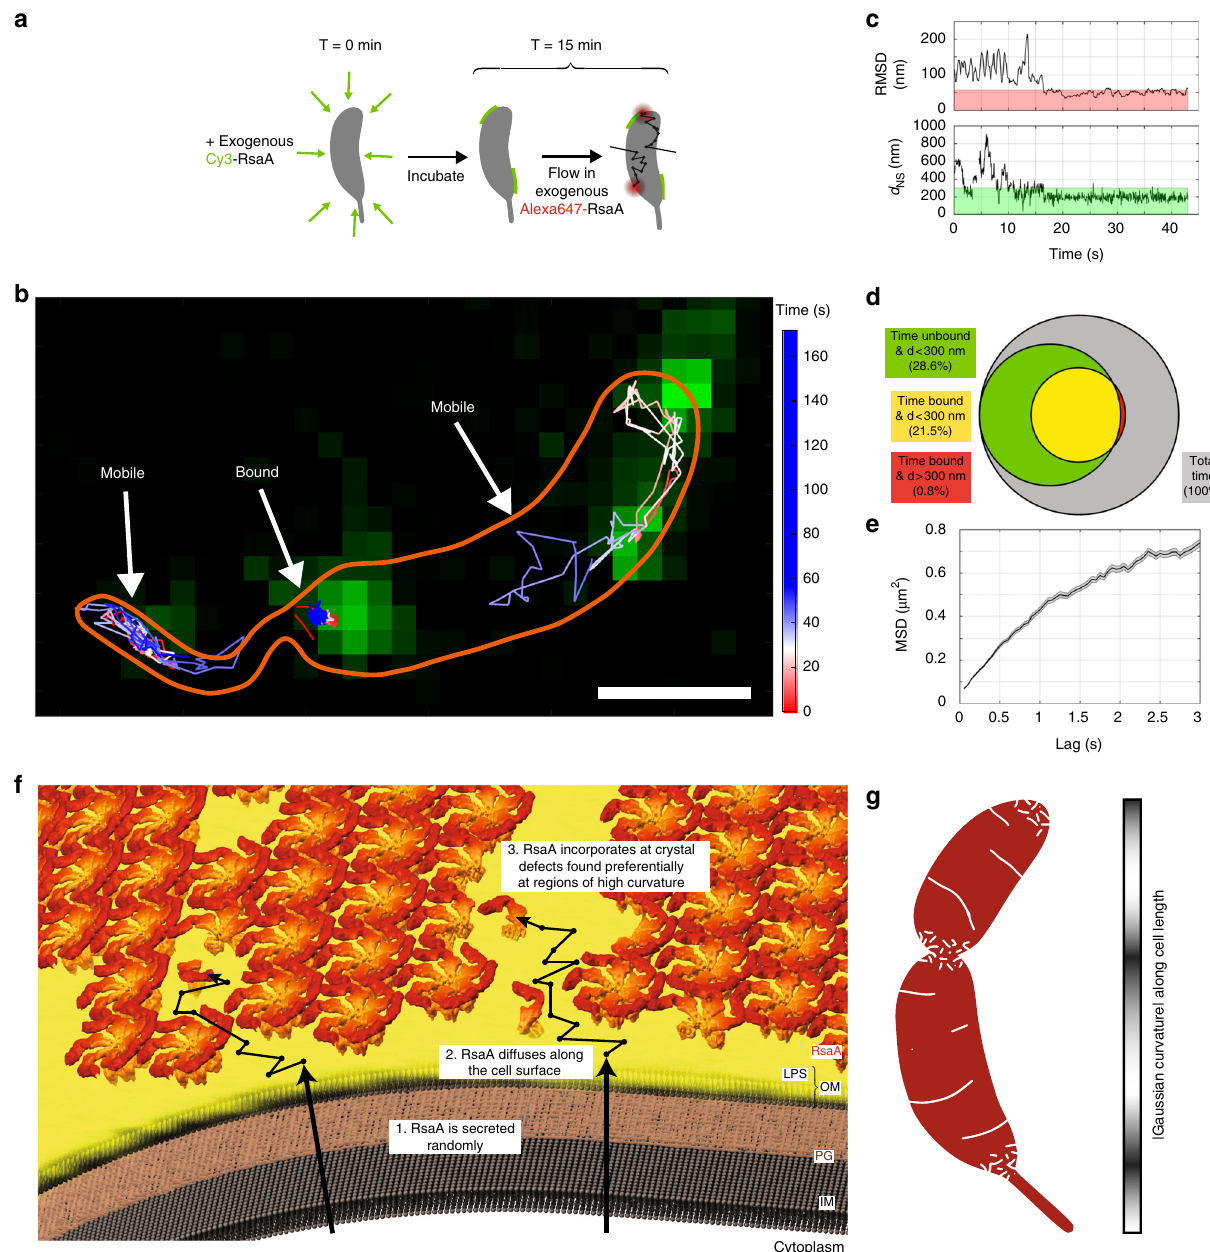
Fig. 4 RsaA monomers diffuse on the outer surface and bind to S-layer crystals. a Schematic of 2D, 2-color single-molecule tracking of CysRsaA on a Δ RsaA cell. Cells were incubated with 2.5 nM Cy3-labeled CysRsaA (green) to create small fl uorescent seed crystals. Single molecules of AlexaFluor647 labeled CysRsaA diffused through the agarose mounting pad and bound to the cell surface. b Single-molecule tracking (SMT) shows mobile and immobile single-molecule tracks. The cell boundary is sketched in orange. Scale bar = 1 μ m. c Upper: The RMSD from a nearby seed of an example track shows binding of the molecule from ∼ 16 to 43 s. Binding is de fi ned as RMSD < 57.3 nm (red shaded region, see also Supplementary Fig. 8). Lower: Distance from the nearest nucleation seed (d NS ) for the same track shows the molecule binds ∼ 200 nm from the center of a crystal patch. Green shaded region shows the 300 nm threshold used for determining crystal patch proximity. d A quantitative Venn diagram displaying the total time (circle indicated by gray area), and the fractions of time molecules spend near a crystal patch and unbound (green area), near a crystal patch and bound (yellow area), and bound but not near a crystal patch (red area), shows that when molecules cease diffusing, they are almost always in close proximity to an existing crystal patch. e MSD analysis from 3D SMT of AlexaFluor647 labeled CysRsaA molecules revealing a diffusion coef fi cient of D = 0.077 μ m 2 /s. Shaded regions represent SEM. f A generalizable model for S-layer assembly including secretion, diffusion, and incorporation at gaps within the S-layer lattice. g A model for S-layer crystal boundaries/defects (white) mapped onto the C. crescentus surface (red), suggested by Gaussian curvature calculations (gray colorbar, indicating a secretion-independent process (Fig. 1j). During this structure caused by localized cell wall growth or the inherent experiment, the long crack-like features observed on the cell body topology of the cell surface (Fig. 4g). Reconstituting S-layer during native assembly (Fig. 1f) are replaced by more widespread, assembly using the stepwise addition of exogenously puri fi ed punctate fl uorescence signal (Fig. 1h). Reconstituting the S-layer CysRsaA yielded a non-uniform pattern of S-layer assembly,